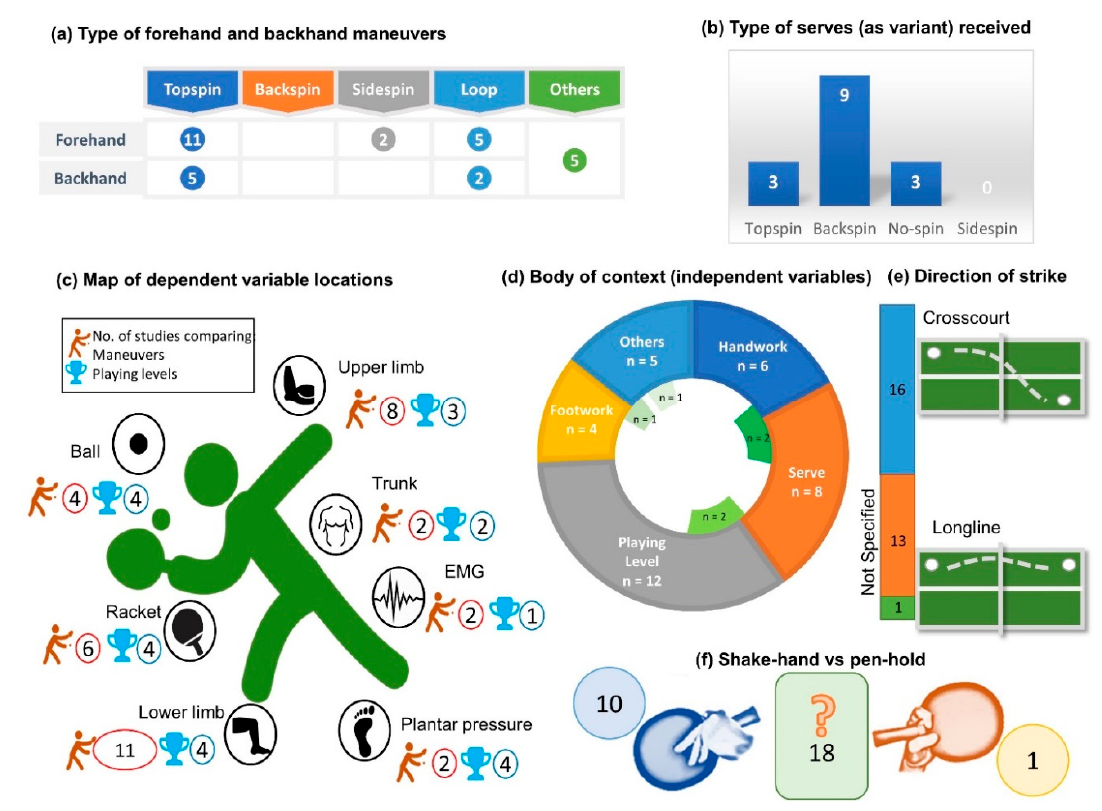
Figure 2. A scoping review map summarizing: ( a ) types of forehand and backhand maneuvers; ( b ) types of serves (as variant) to hit back; ( c ) map of dependent variables comparing the number of studies between topics on maneuvers and playing levels; ( d ) body of context (independent variables), the n-values in the interior circle denote number of studies with multiple independent variables between or within the factors stated on the exterior circle; ( e ) direction of strike; and ( f ) shake-hand vs pen-hold.